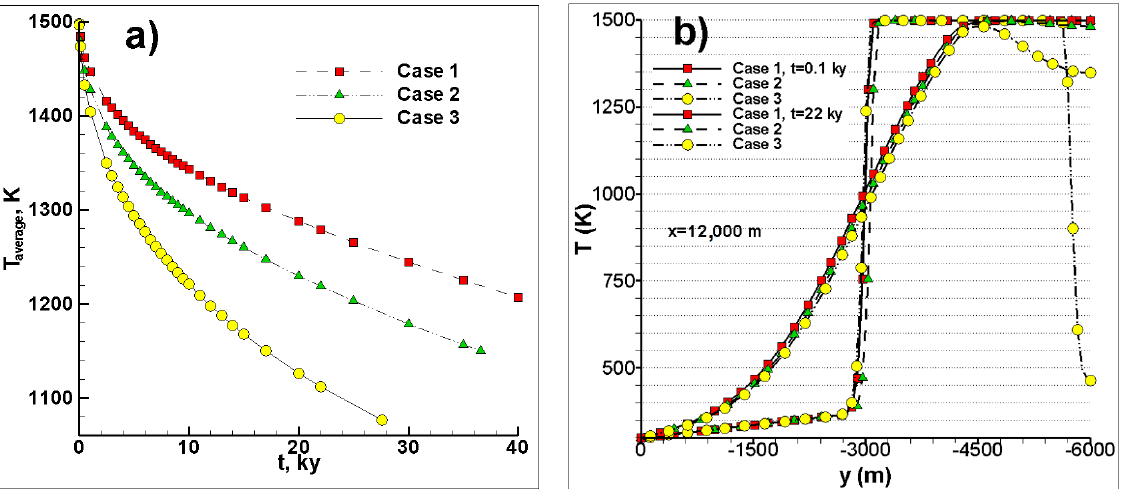
Figure 5. For the three cases studied: ( a ) Temporal evolution of the temperature average inside the chamber and ( b ) temperature profile (for x = 12,000 m) at two different times in the host rock and chamber.